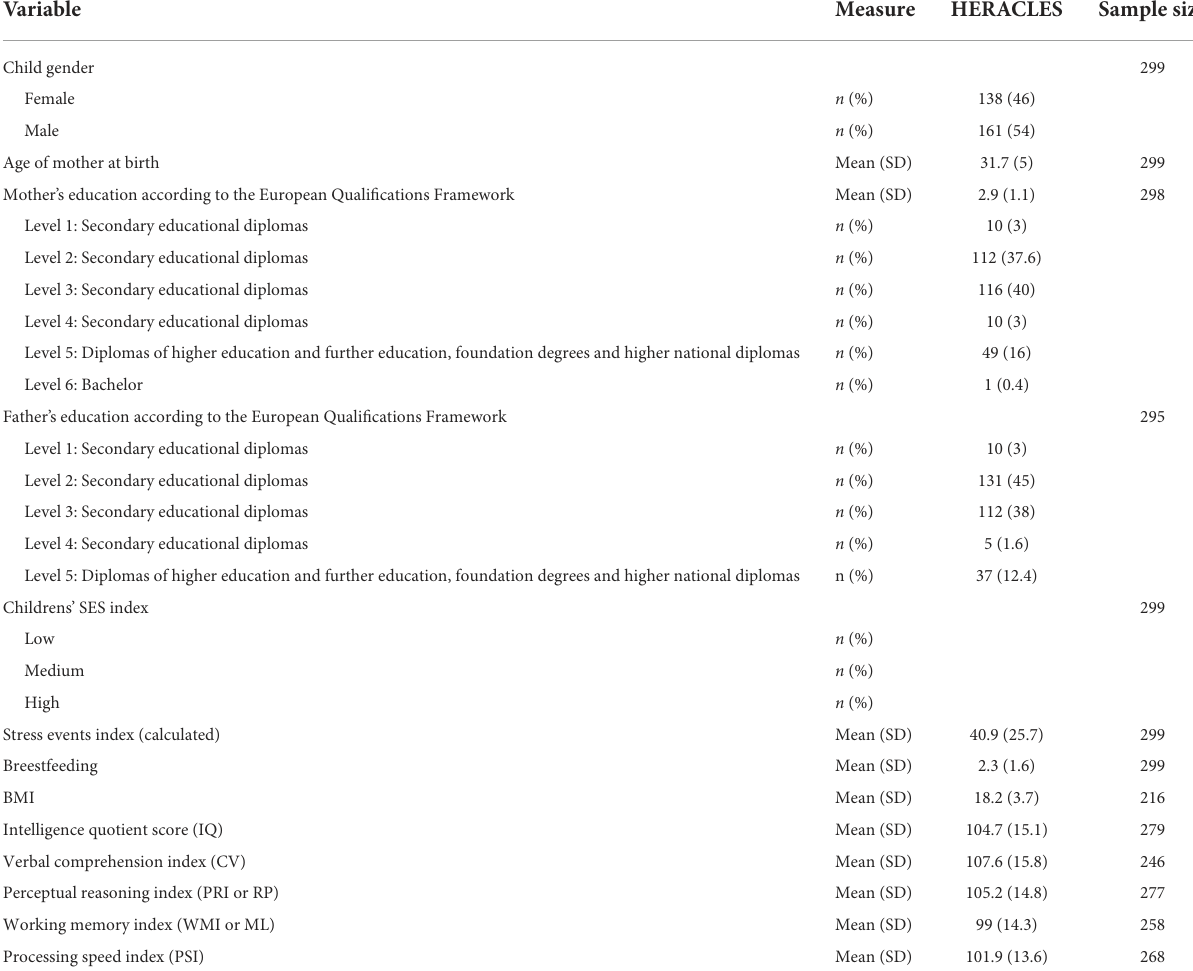
TABLE 2 Characteristics of the study population (HERACLES Cohort), and Bayley scores for cognitive, language and motor Bayley-III scores. Variable Measure HERACLES Sample